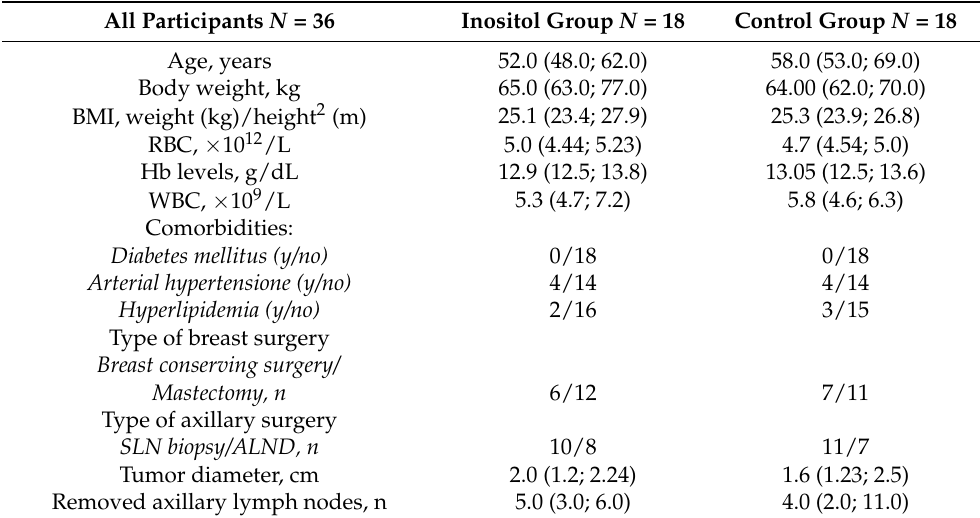
Table 1. Patients’ characteristics at